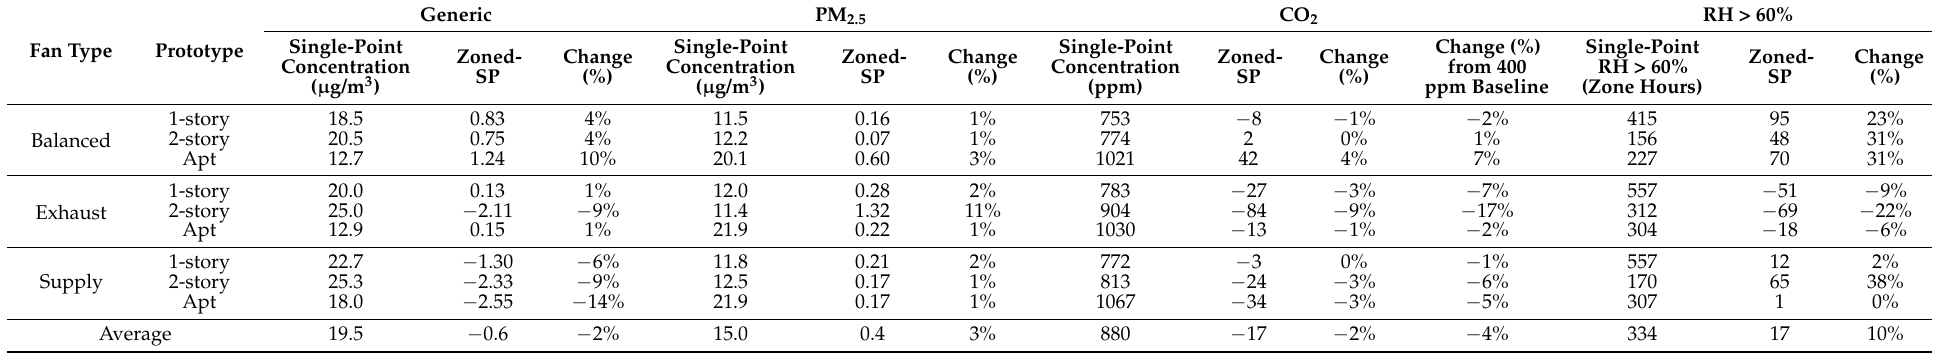
Table 3. Annual average results comparing zoned and single-point ventilation configurations for baseline constant flow cases. Highlighted cells show changes greater than +/ − 5%.